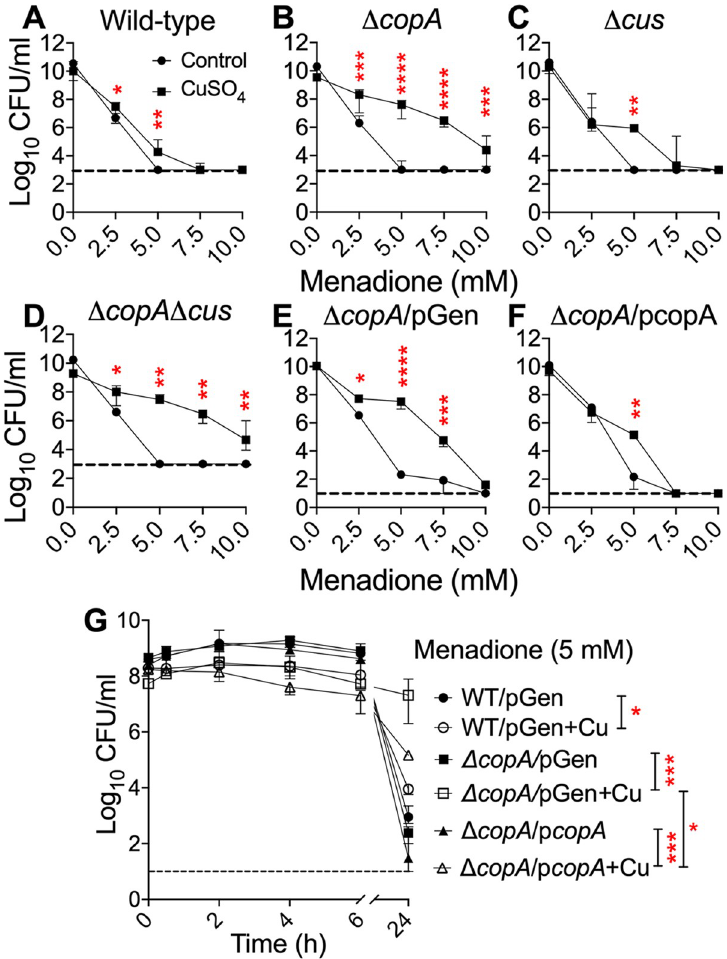
Fig 1. Pre-exposure to copper protects UPEC from killing by superoxide. Wild-type UPEC strain CFT073 (A), Δ copA (B), Δ cus (C), Δ copA Δ cus (D), Δ copA/ pGen (E), and Δ copA/ p copA (F) strains were grown in LB (circles) or LB with copper (squares) to early logarithmic phase (OD 600 = 0.3, ~10 8 CFU/ml). Menadione was added at indicated concentrations, and incubated for 24 h prior to enumeration of viable bacteria. (G) Time course of survival of wild- type, Δ copA , and Δ copA/ p copA strains pre-treated with copper (+Cu) or controls. Median ± interquartile range of CFU/ml from 3 independent experiments is presented. Dashed line, limit of detection (1000 or 10 CFU/ml). � P < 0 . 05 , �� P < 0 . 01 , ��� P < 0 . 001 , ���� P < 0 . 0001 , Mann-Whitney test.